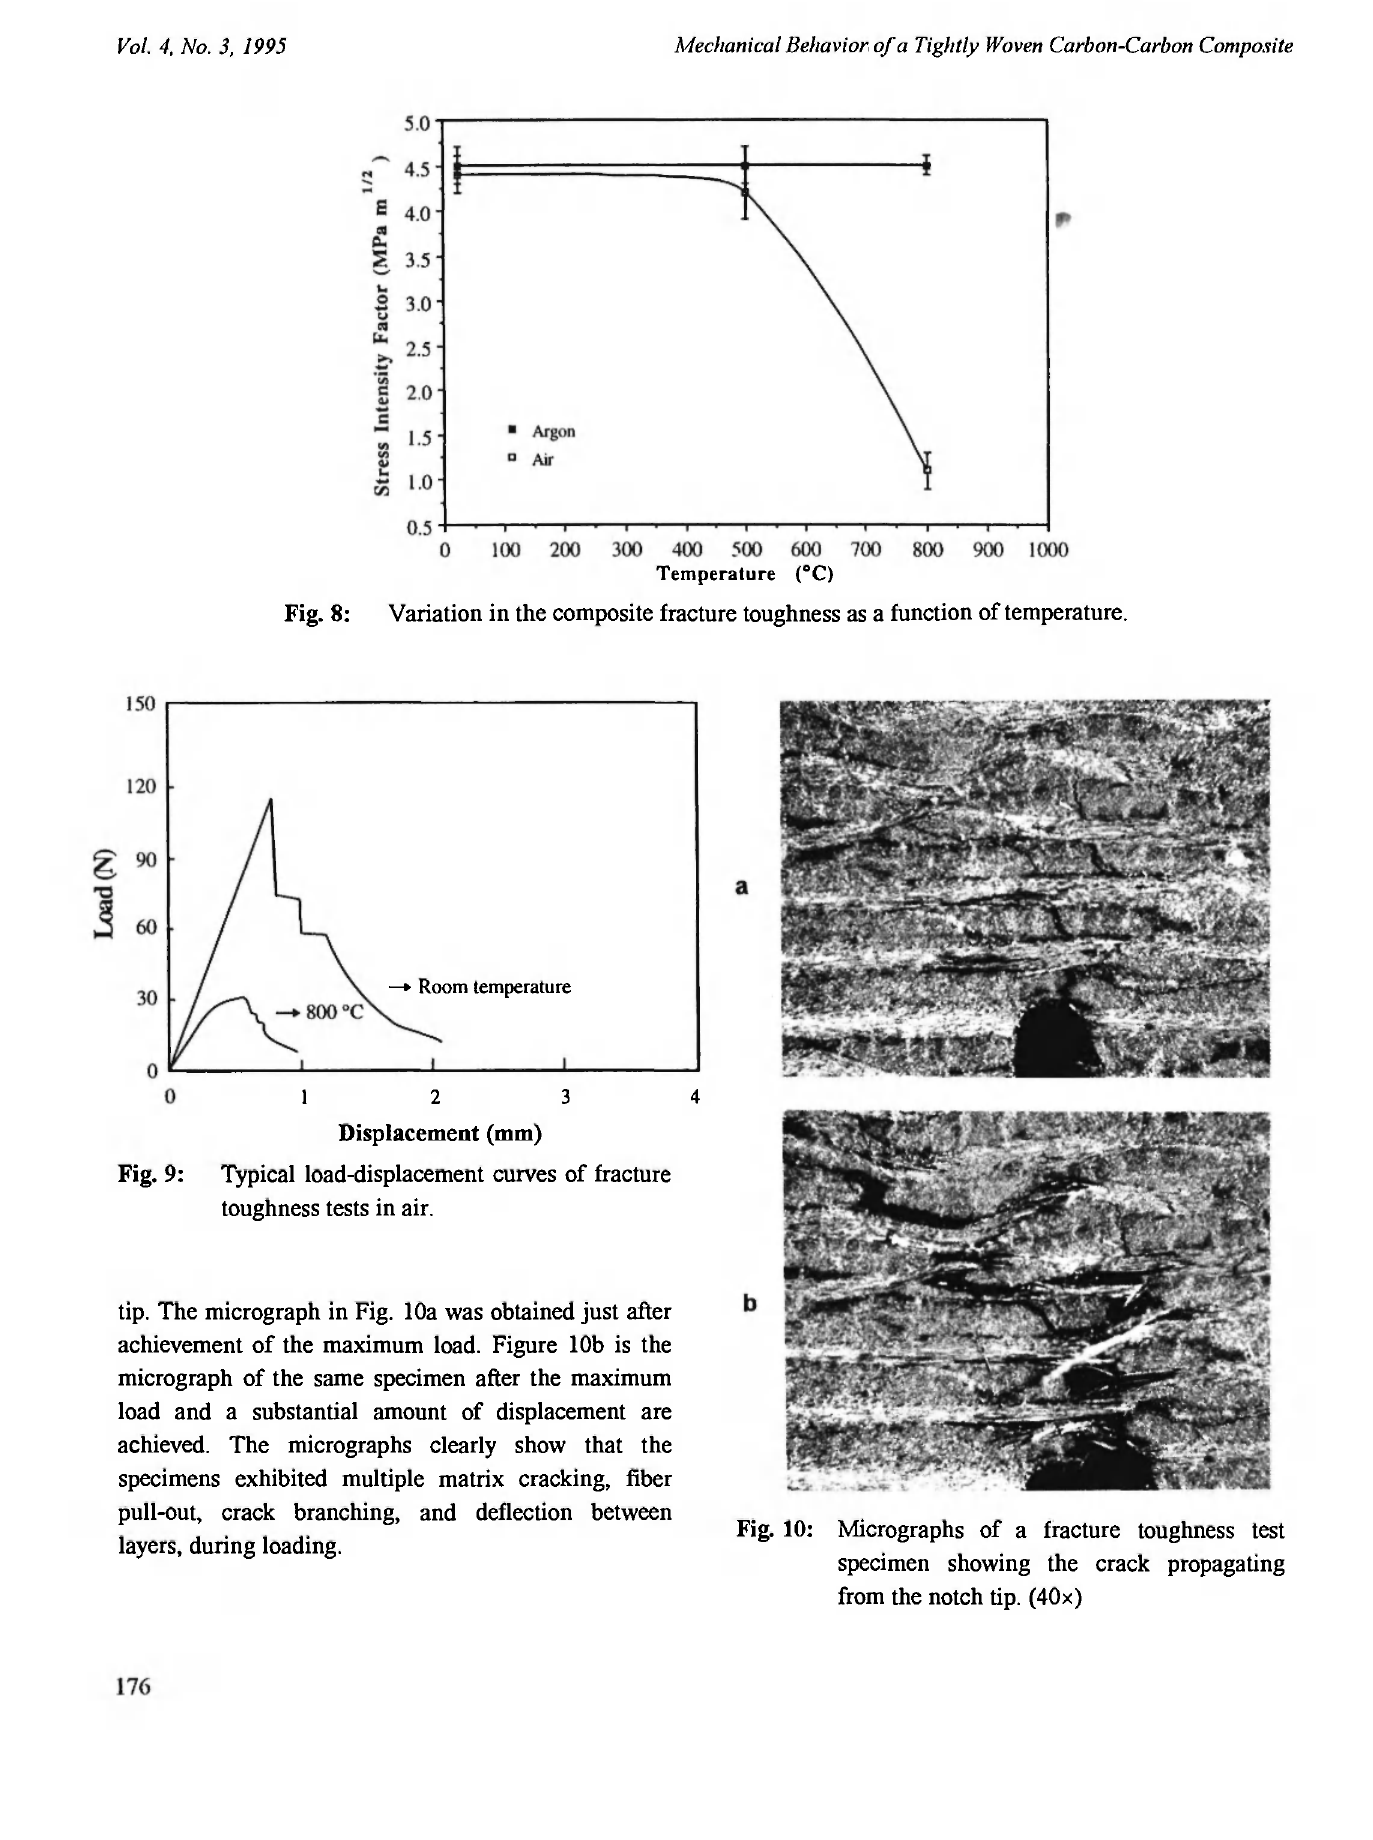
Fig. 10: Micrographs of a fracture toughness test specimen showing the crack propagating from the notch tip. (40x)